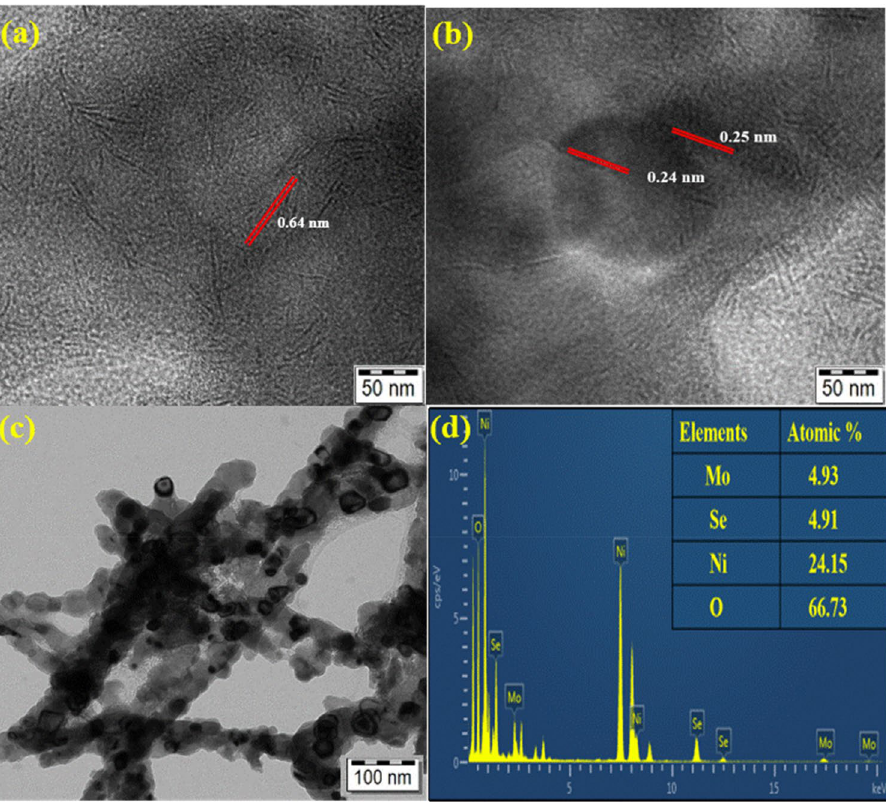
Figure 4. ( a , b ) High-resolution HR-TEM images of NiO/MoSe 2 with the measured lattice spaces. ( c ) HR-TEM image and ( d ) EDX spectrum of the NiO/MoSe 2